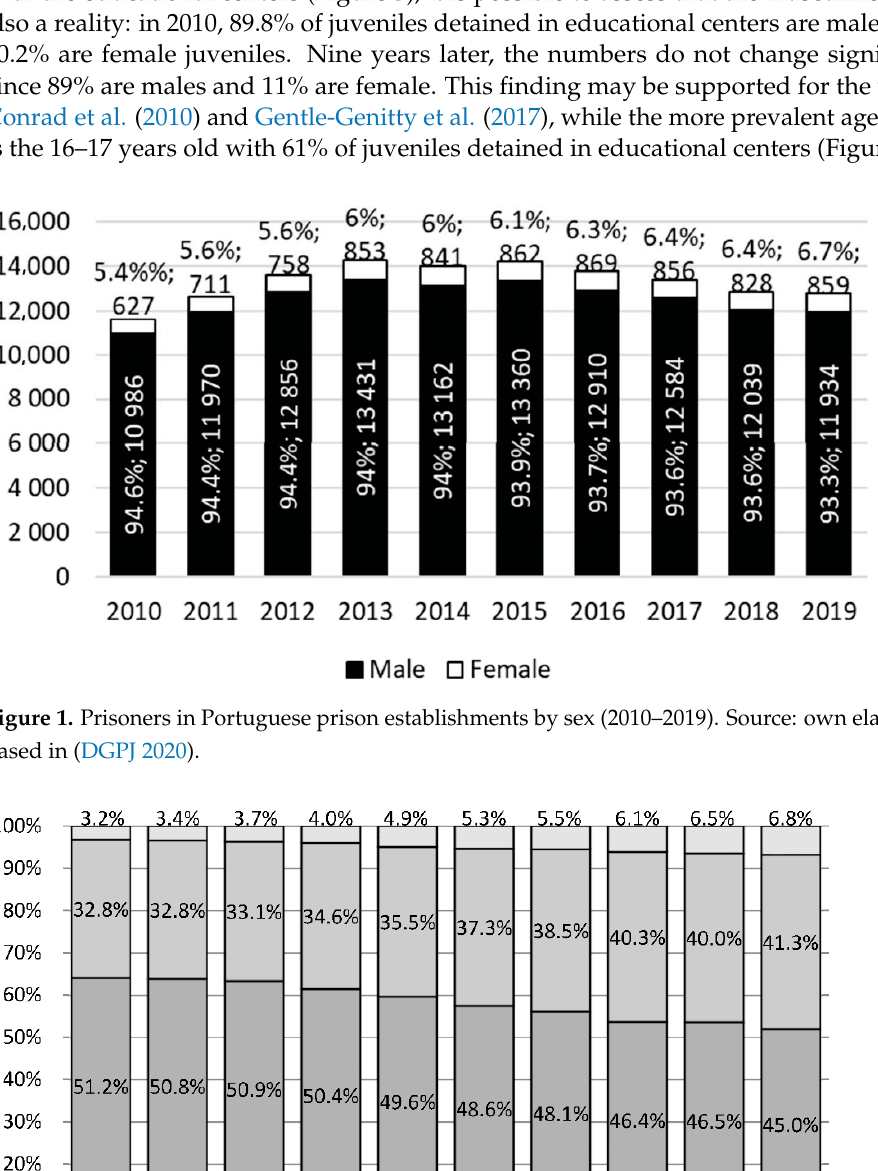
Figure 3. Juveniles detained in educational centers by sex (2010–2019). Source: own elaboration, based in DGPJ 2020.